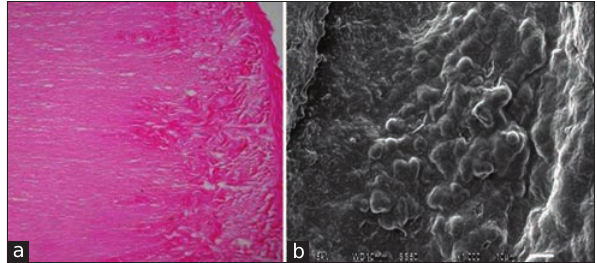
Figure-2: (a) Microscopically native fish swim bladder (FSB) showing cellularity and compact fiber arrangement (hematoxylin and eosin stain, ×40), (b) native FSB showing cellularity and compact fiber arrangement (scanning electron microscopy observation,